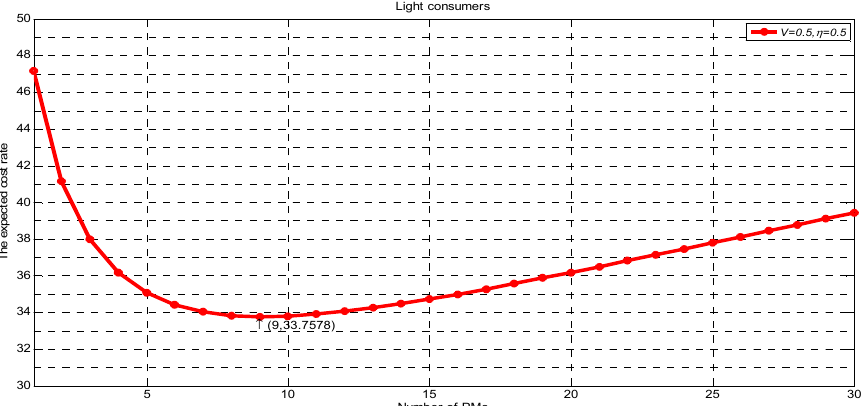
Figure 6. The feasibility of BPWM.